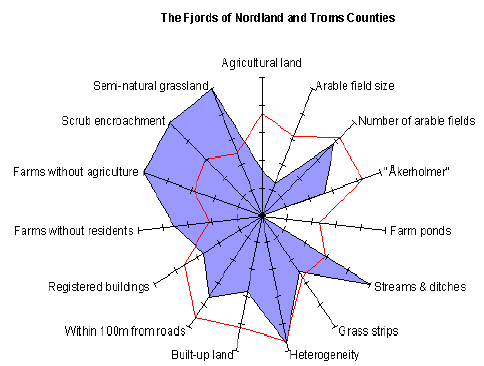
Figure 2. Fjord districts of the counties Nordland and Troms. The red line is the average of the country and the blue is the condition in these districts. The northern district of Norway has a climate that makes the agricultural land very small. This chart also shows that there are a lot of farms without agriculture and without residents. The depopulation is high in these